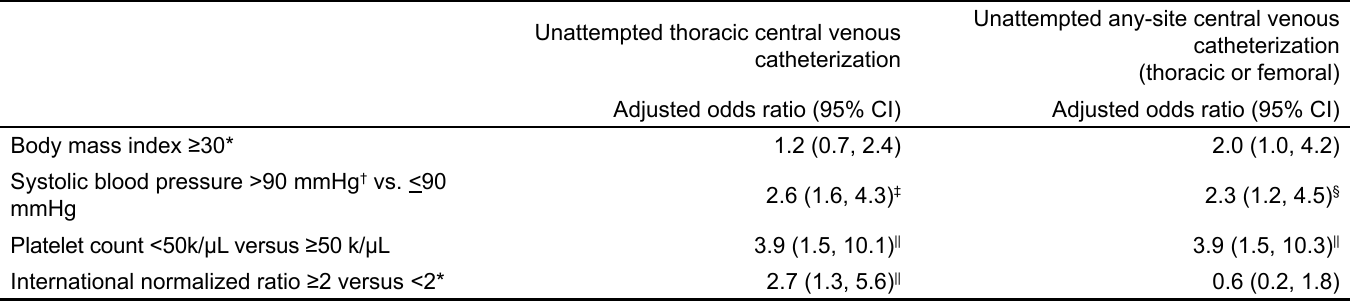
Table 2. Adjusted associations between patient characteristics and unattempted thoracic central venous catheterization in septic emergency department patients eligible for early goal-directed therapy